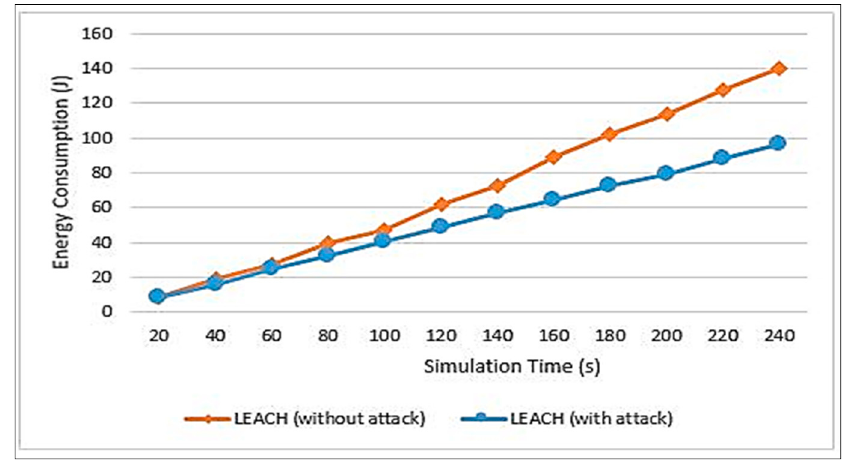
Figure 9. Energy consumption measurement.